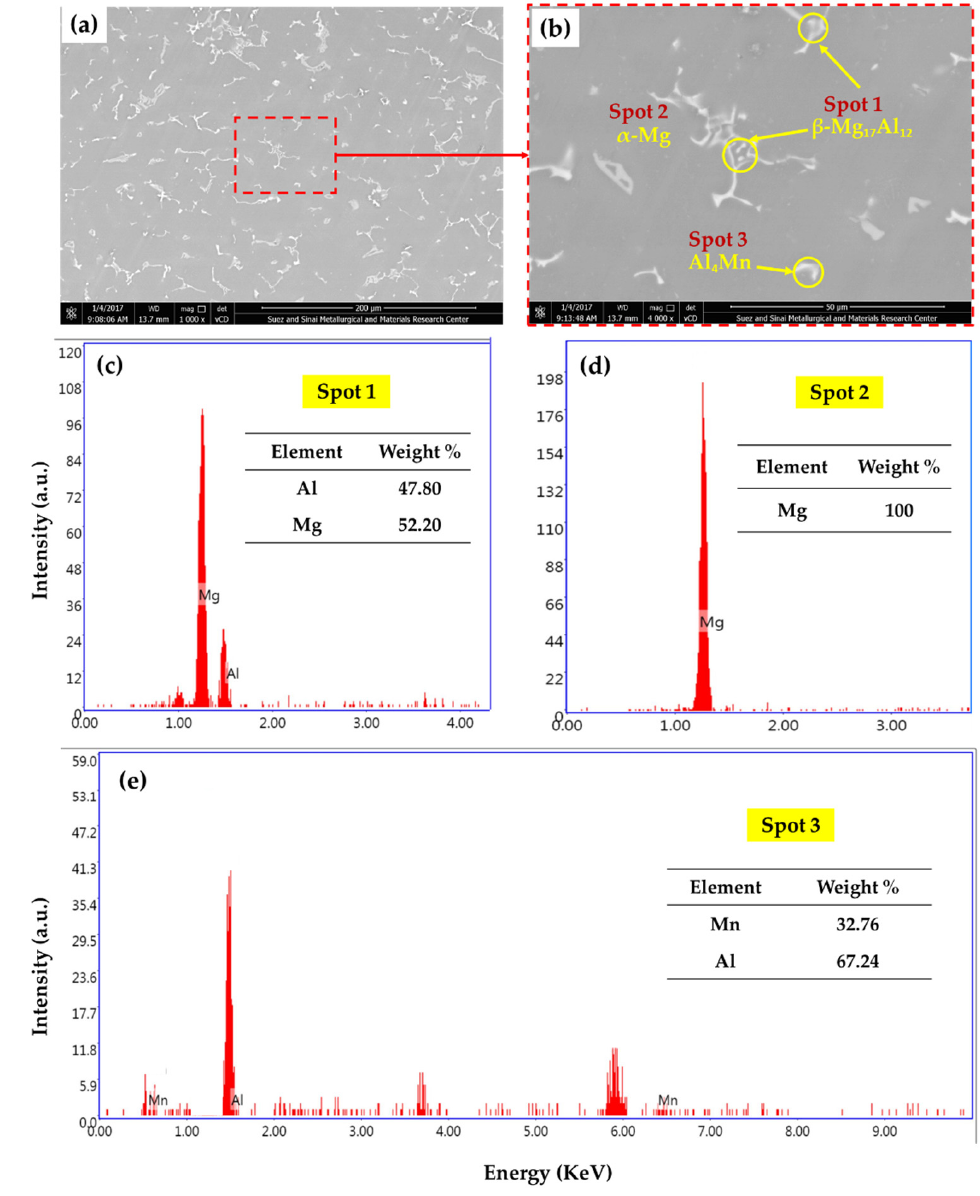
Figure 3. SEM images at ( a ) low and ( b ) high magnification of the AZ91-BM and the EDS analysis of the AZ91 intermetallics; ( c ) spot 1, ( d ) spot 2, and ( e ) spot 3 in subfigure ( b ).